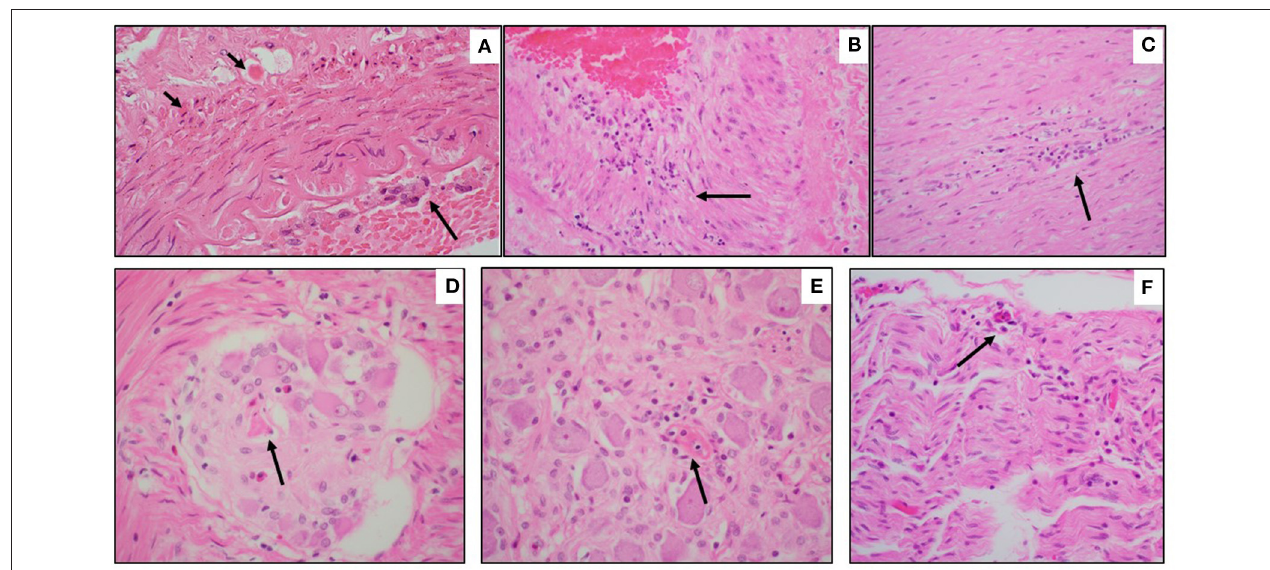
FIGURE 3 | Microscopic neuropathology in Case 5. (A) Left MCA with arteritis, characterized by endotheliitis (long arrow) and individually necrotic vascular smooth muscle cells (short arrows) (H&E, 200x). (B) Coronary arteritis, with full-thickness mural inflammation (arrow) (H&E, 200x). (C) Aortitis, with mural inflammation (arrow) (H&E, 100x). (D) Myenteric ganglionitis, with necrotic neuron (arrow) (H&E, 400x); (E) Sympathetic ganglionitis, with rare fibrinoid vessel (arrow) (H&E, 200x); (F) Celiac nerve with inflammation and endothelial prominence (arrow) (H&E, 100x).